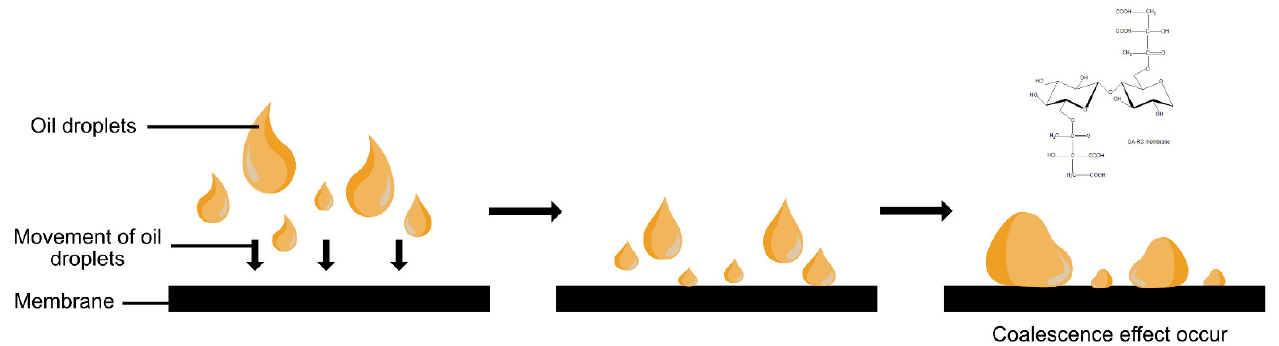
Figure 6. Formation of the hydrated sheath on RC membrane with CA crosslinking.